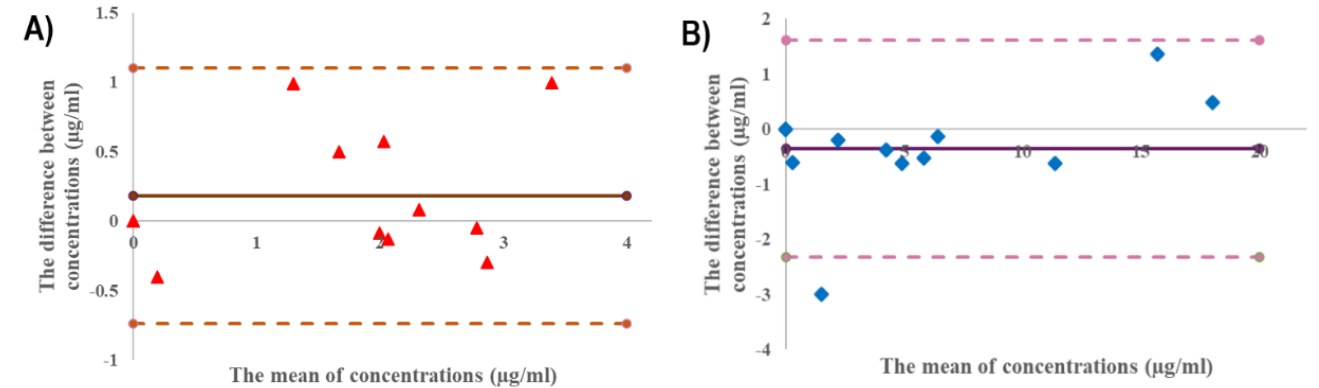
Figure 8. Bland–Altman graphics for the comparison of the two analytical techniques for the release of DOX ( A ) and SIM ( B ).